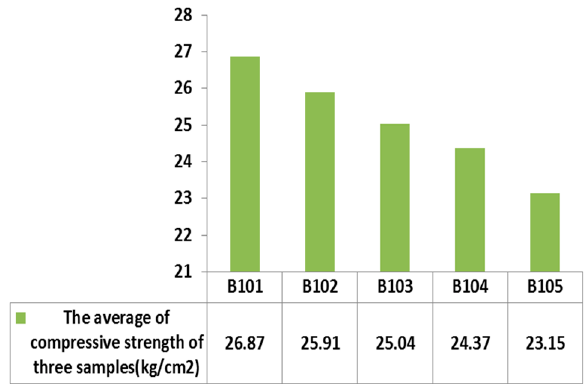
Figure 9. The test results of volume water absorption (kg/m 3 ).